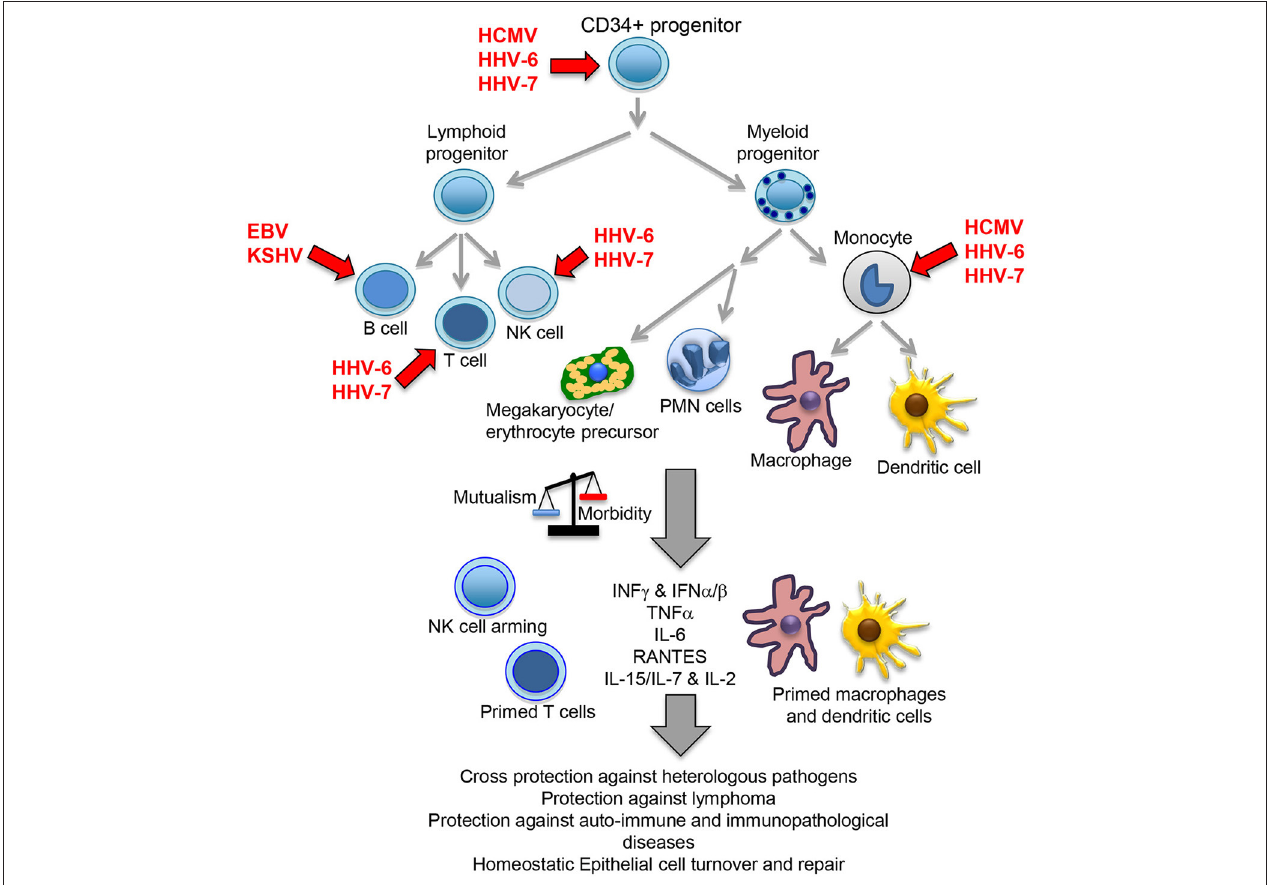
FIGURE 1 | Beta- and gamma-herpesvirus mutualistic relationship with human host. While a restricted B cell tropism is usually found in vivo for gamma-herpesviruses, a wide tropism is observed for beta-herpesviruses that includes CD34 positive early progenitors, T cells, NK cells, monocytes, macrophages and dendritic cells. In homeostatic conditions, the herpesvirus immunomodulatory mechanisms positively influence host immunity, cross-protecting against heterologous pathogens through NK cell arming, and perhaps also due to their capacity to increase the numbers of T and NK cells, plus bystander activation through increased levels of local and systemic cytokines. Viral immunomodulation also improves tumor immunosurveillance, protects against auto-immune/immunopathological diseases and cooperate with other homeostatic processes, such as epithelial cell turnover and repair. A primed state indicates a possible pre-activated form of the immune cells triggered by IFN γ or other cytokines. PMN, polymorphonuclear cells.